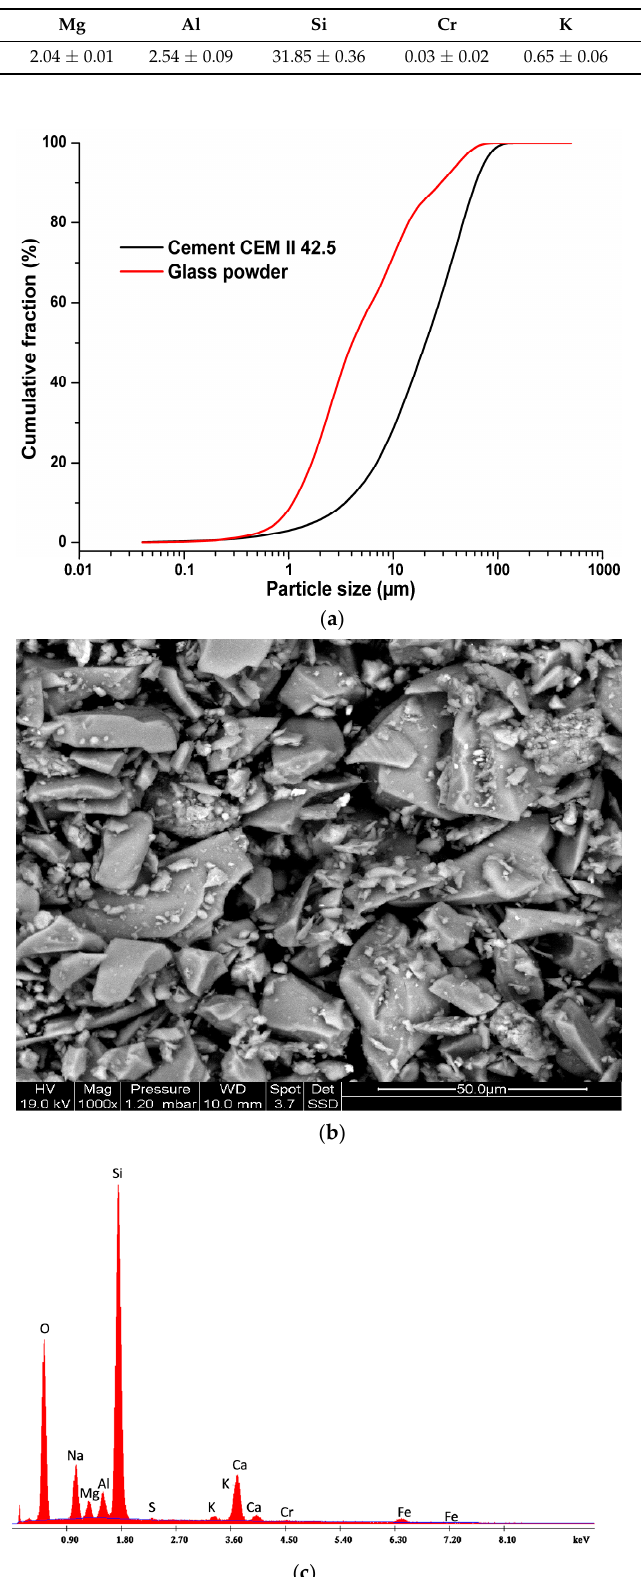
Figure 1. Physico-chemical characteristics of glass powder used: ( a ) grain size distribution, ( b ) particle shape and ( c ) chemical components distribution.